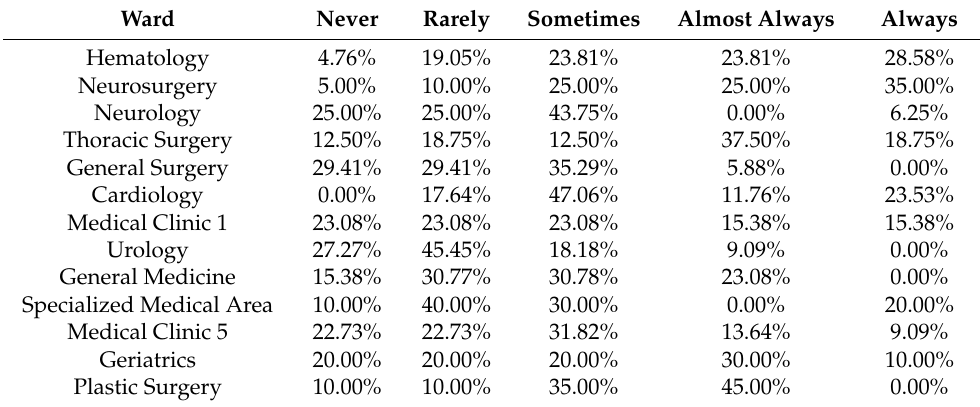
Table 3. Different answers of the wards in relation to question